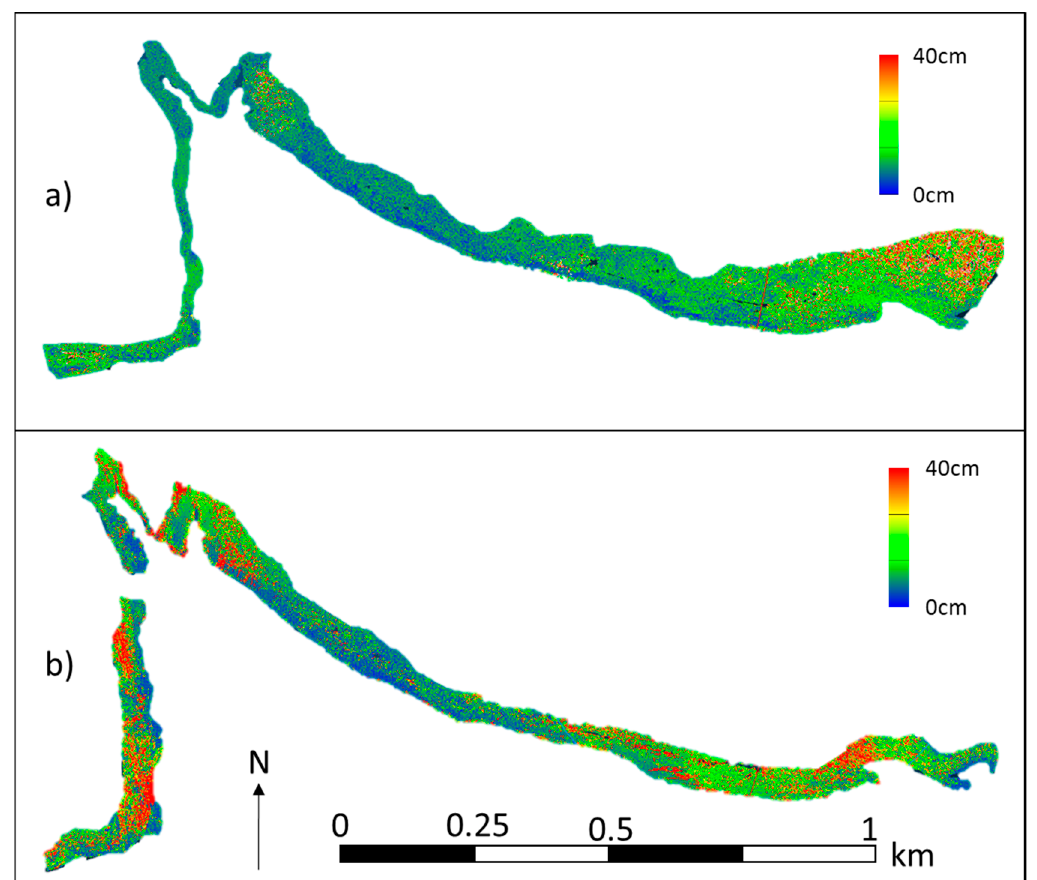
Figure 7. Effects of models created with different GCP spacing compared to the reference model generated with 0.4-km (quarter mile) spacing. Panel ( a ) shows the model generated using 0.8-km spacing, which has an average error of 4.5 cm, and panel ( b ) shows the results from the model generated with the 1.6-km spacing, which has an average error of 5.5 cm. The maximum errors occurred in steep banks, well above the water elevation in most cases. In panel ( b ), there is a region in the bottom left with larger errors near the reservoir elevation. This area, shown in red in panel ( b ), has almost vertical banks, so very small changes in x-y positions can result in large differences between the reference and generated models.